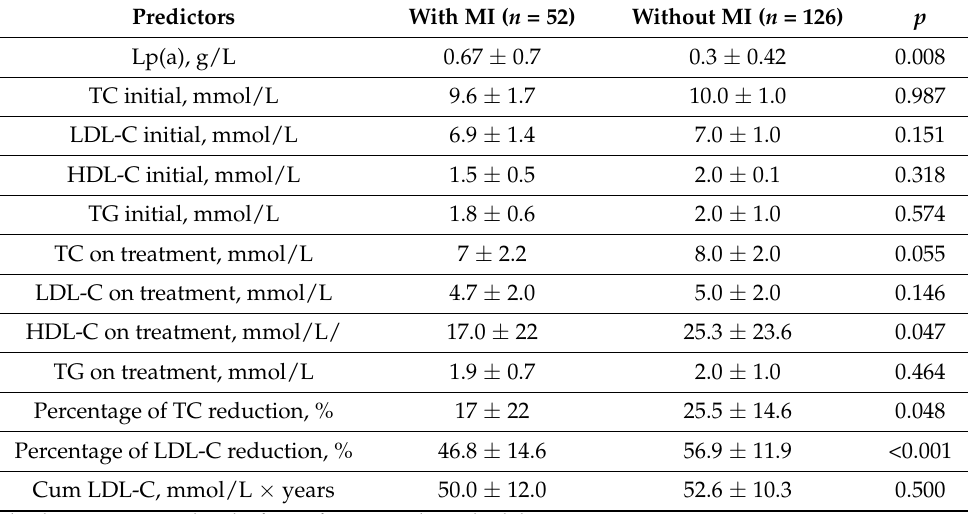
Table 5. Lipid risk factors and MI in FH